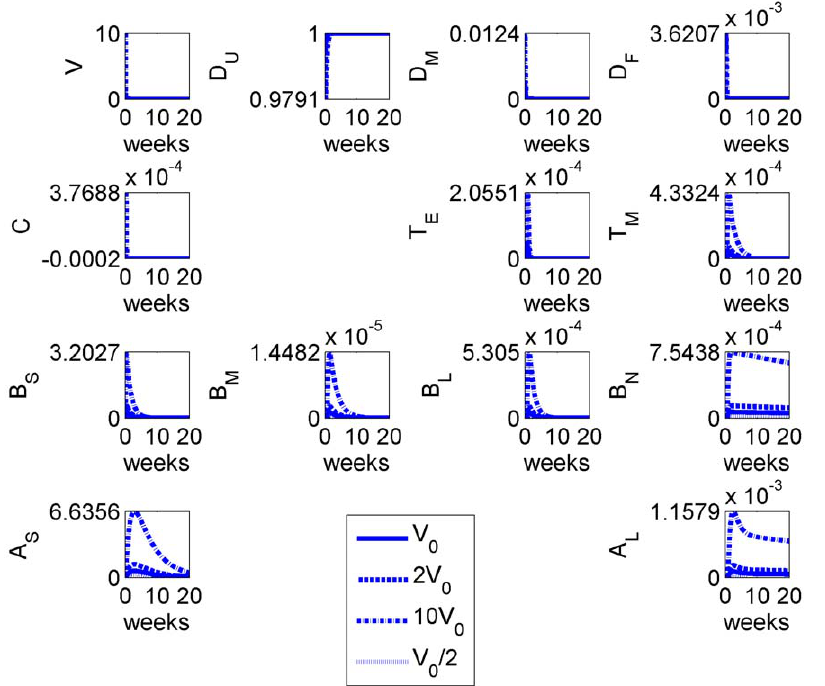
Figure 3. Model results for the system with different initial doses of (stable) vaccine: V 0 (solid), 2 V 0 (dashed), 10 V 0 (dot-dashed) and V 0 = 2 (dotted).